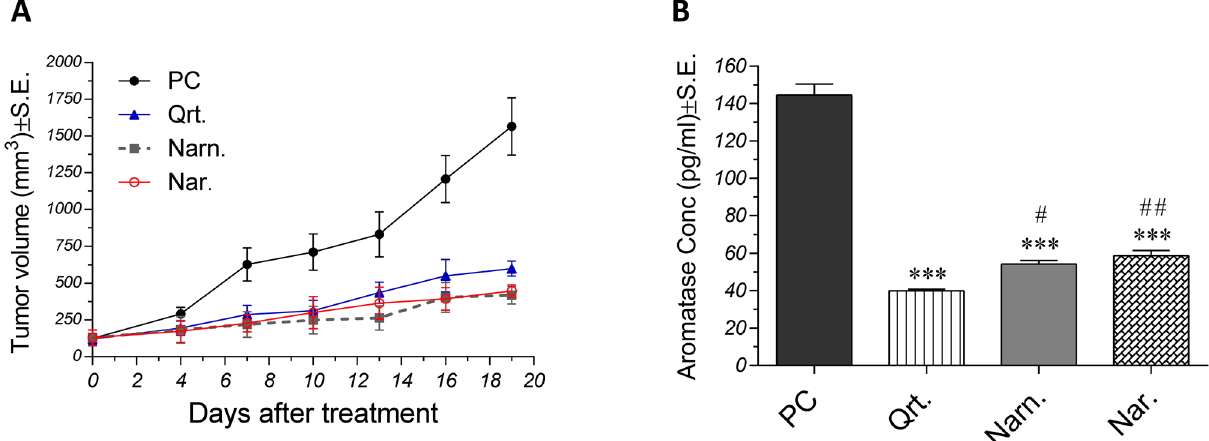
Figure 5. Effect of quercetin, naringenin and naringin on tumor volumes and aromatase levels in solid tumors. ( A ) Effect of flavonoids on tumor volumes (means ± S.E.) of Ehrlich Ascites Carcinoma (EAC)-bearing mice. Treatment was started 5 days after inoculation of EAC cells. Tumor volumes were measured at 4, 7, 10, 13, 16, and 19 days after starting treatment. ( B ) Effect of flavonoids on aromatase levels (means ± S.E.) in solid tumors of EAC-bearing mice determined using ELISA. Data were analyzed using One Way ANOVA followed by Tukey–Kramer post hoc test (n = 10). ***Significant at p < 0.0001 compared to control, # Significant at p < 0.05 compared to quercetin, and ## Significant at p < 0.01 compared to quercetin. PC positive control, Qrt quercetin, Narn naringenin, Nar